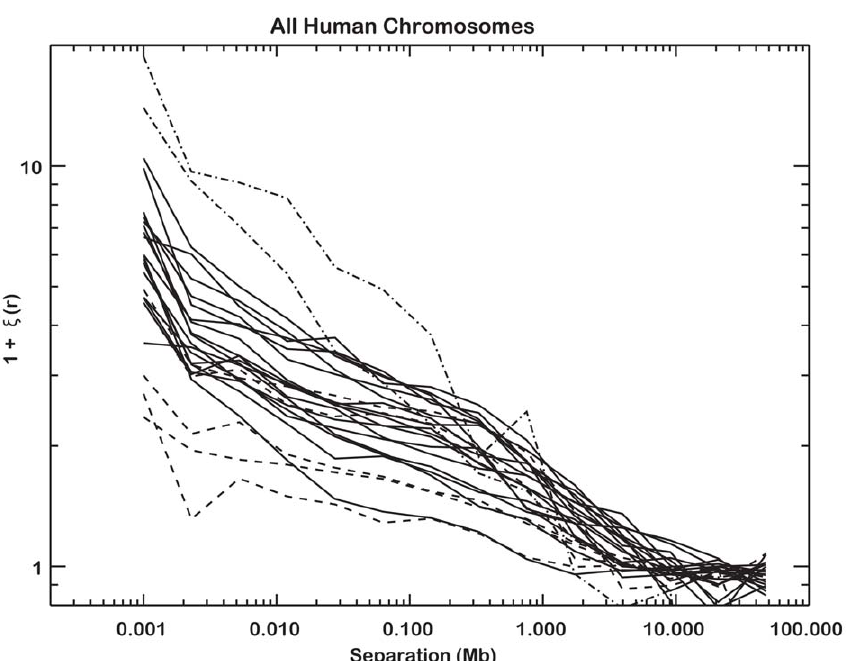
Figure 3. Summary of TPCF for all human chromosomes. Dashed lines show high CGI density chromosomes, dash-dot lines represent (top to bottom) the Y and X chromosomes. Inter-chromosomal variation is clear, and in general all chromosomes show random clustering by , 10 Mb. Large separations likewise produce significant clustering, due to the high density of CGI in telomeres. Typical error bars for a given 1 + j are shown to the right. Individual profiles for each chromosome can be found in Figure 2 and the Supplemental Figures.